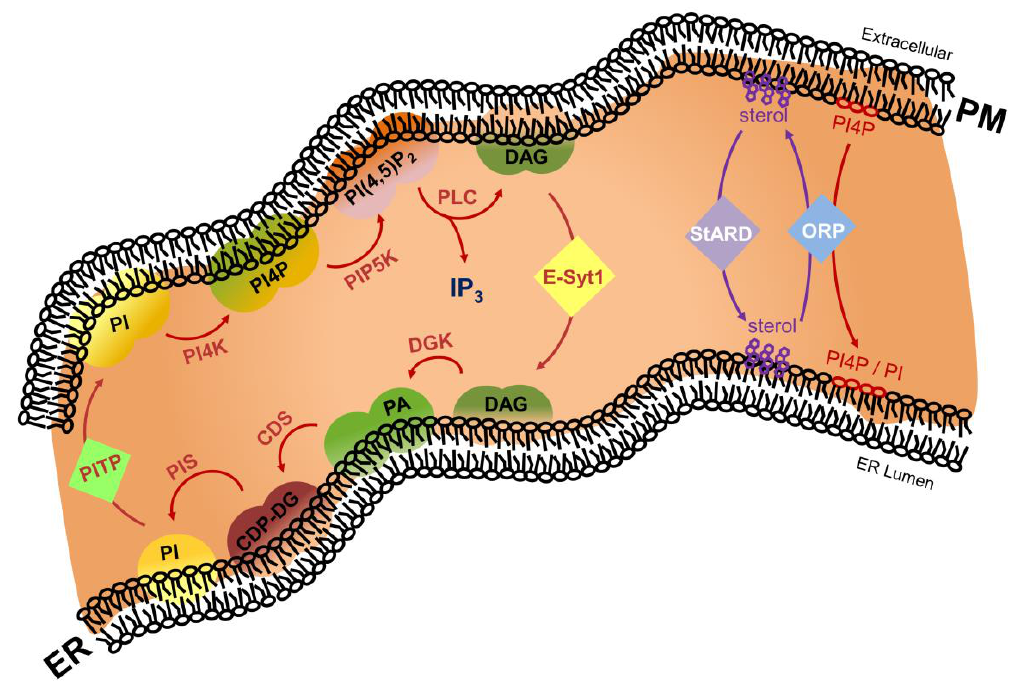
Figure 3. In the phosphoinositide cycle, phosphatidylinositol (PI) is sequentially converted to phosphatidylinositol 4-phosphate (PI4P) and phosphatidylinositol 4,5-bisphosphate (PI(4,5)P2) by PI kinase activities at the PM. Upon physiological triggers, phospholipase C (PLC) hydrolyzes PI(4,5)P2, generating the second messenger molecules diacylglycerol (DAG) and inositol trisphosphate (IP 3 ). Extended synaptotagmin 1 (E-Syt1)-mediated non-vesicular transport of DAG from PM allows conversion of DAG into PI, PI4P, and PI(4,5)P2 at the ER [131]. PI4P species are transferred from the PM to the ER by oxysterol-binding protein-related protein (ORP). Cholesterol is cycled between the PM and the ER through the sequential actions of Star-related lipid transfer protein/Gram domain-containing protein (StARD/GRAMd) and ORP proteins. Additional abbreviations: ER, endoplasmic reticulum; PM, plasma membrane.